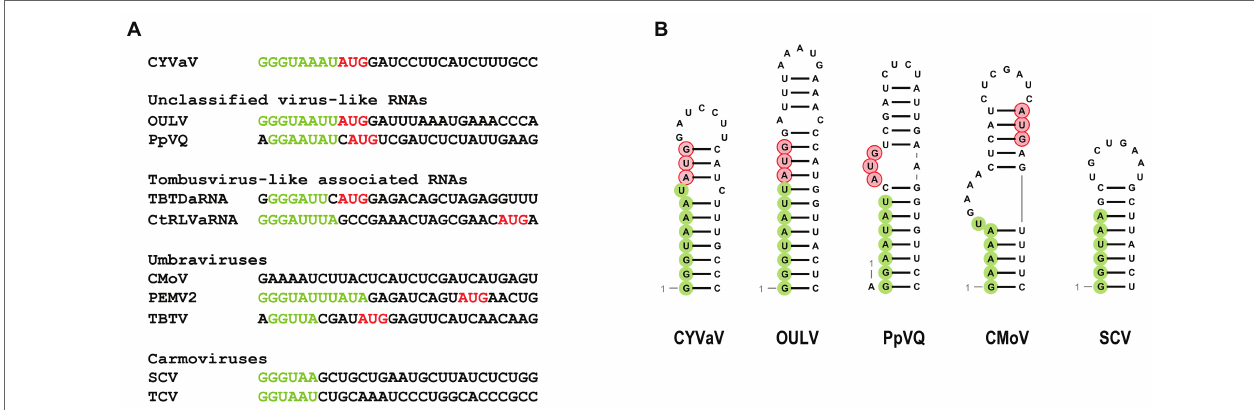
FIGURE 5 | Sequences (A) and the predicted secondary structure (B) at the 5 ' ends of CYVaV and selected viruses and virus-associated RNAs. Carmovirus consensus sequence (CCS) is in green and initiation codons for 5 ' ORFs are in red. Unclassified virus-like RNAs; OULV and PpVQ. Tombusvirus-like associated RNAs; tobacco bushy top disease-associated RNA (TBTDaRNA) and carrot red leaf virus associated RNA (CtRLVaRNA). Umbravirus; carrot mottle virus (CMoV), PEMV2, and tobacco bushy top virus (TBTV), Carmovirus; saguaro cactus virus (SgCV) and turnip crinkle virus